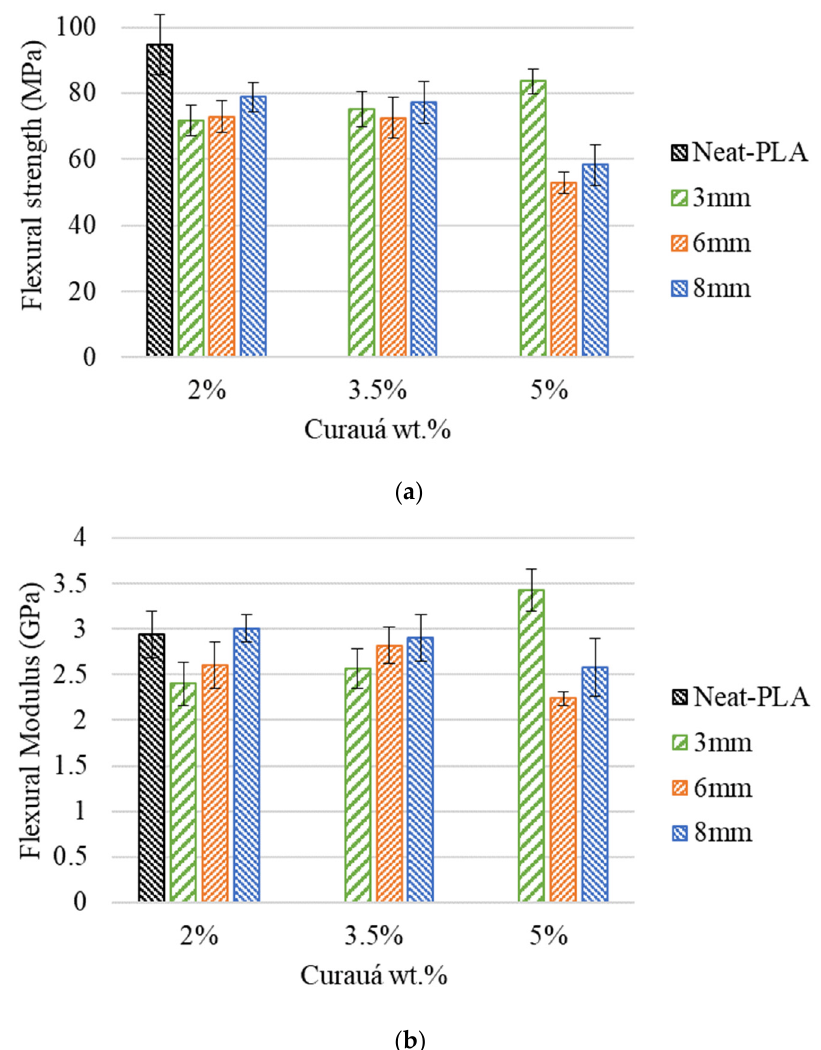
Figure 9. Flexural data of all composites as a function of fiber length and wt.%: ( a ) flexural strength and ( b ) flexural modulus.